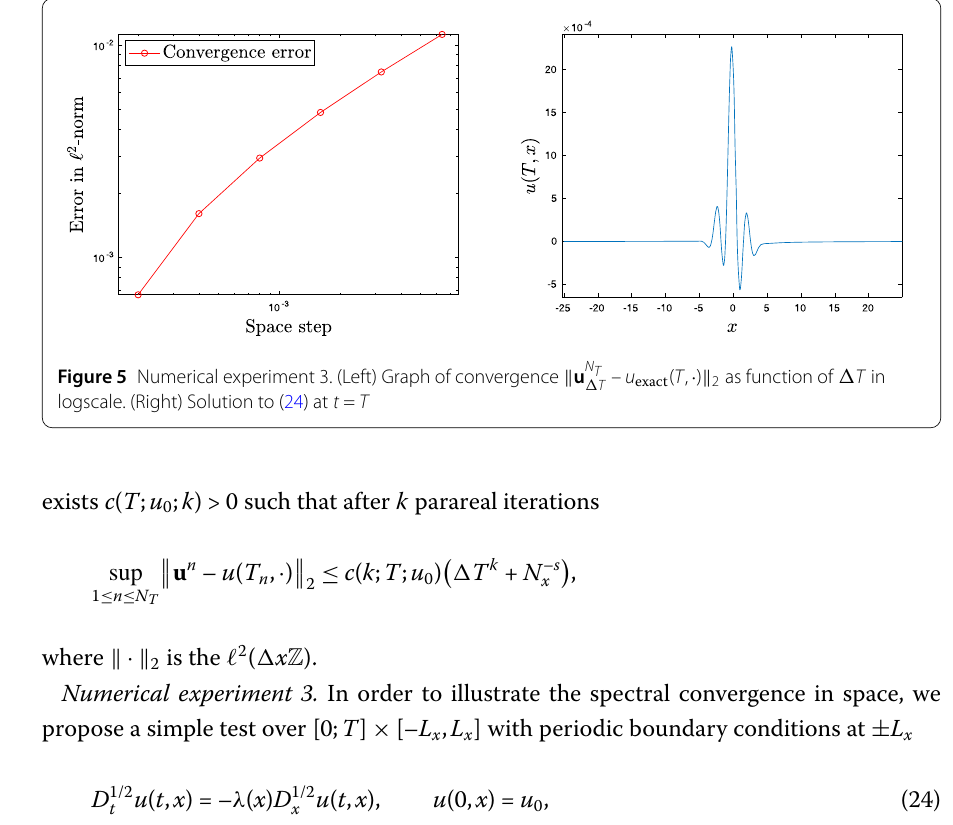
exists c ( T ; u 0 ; k ) > 0 such that after k parareal